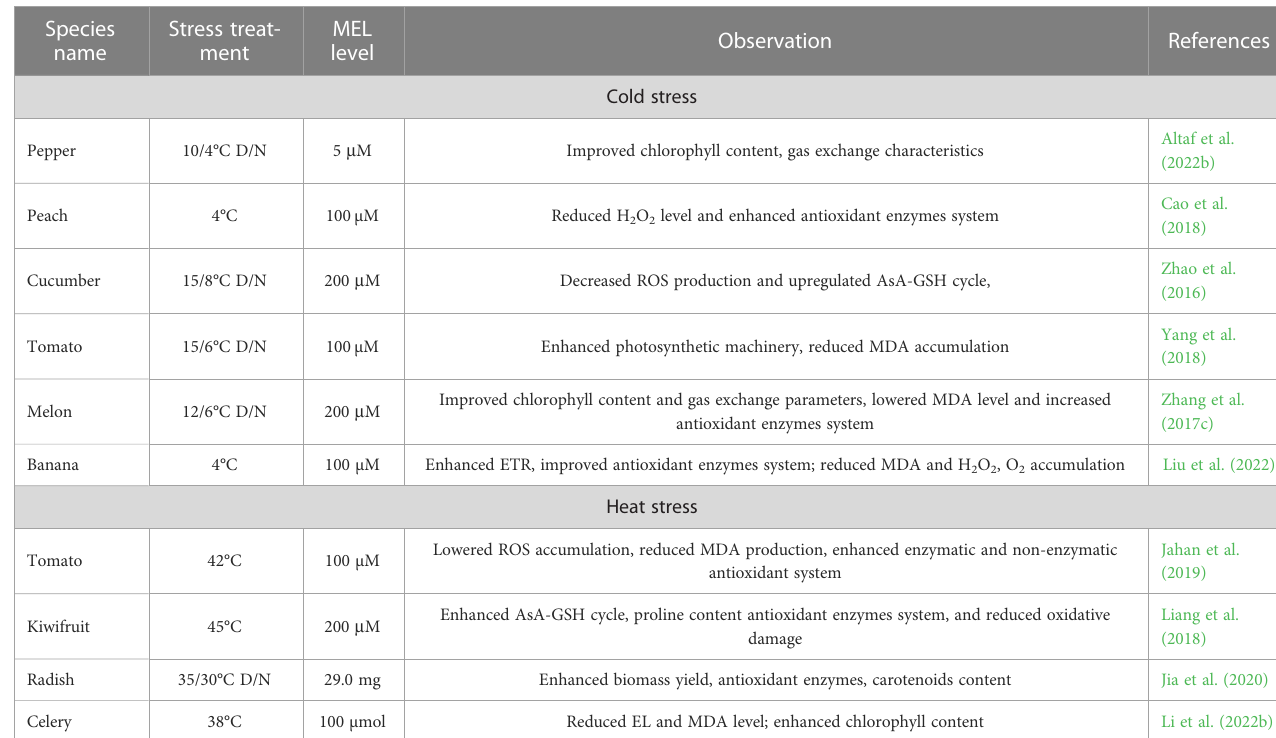
TABLE 4 Action of melatonin in cold and heat stress